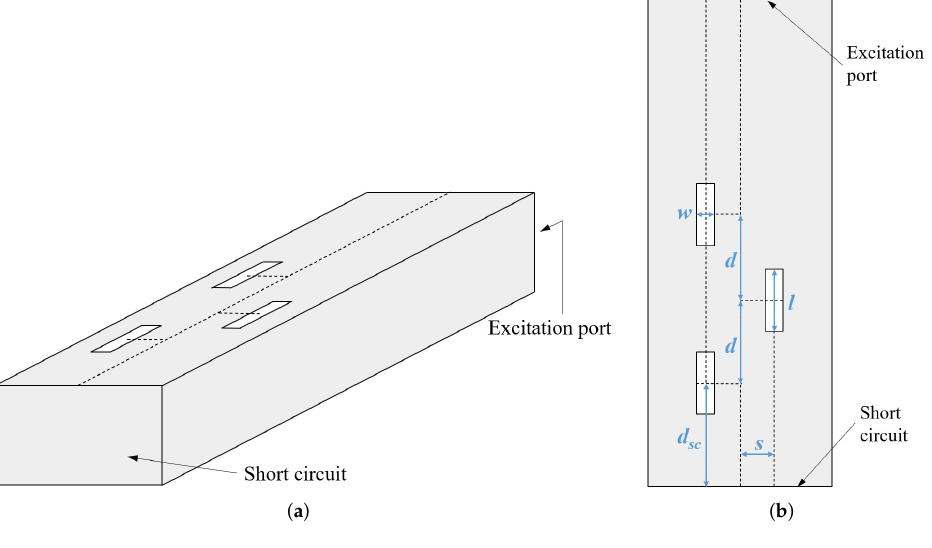
Figure 1. Textile slotted waveguide antenna: ( a ) Side-view, ( b )